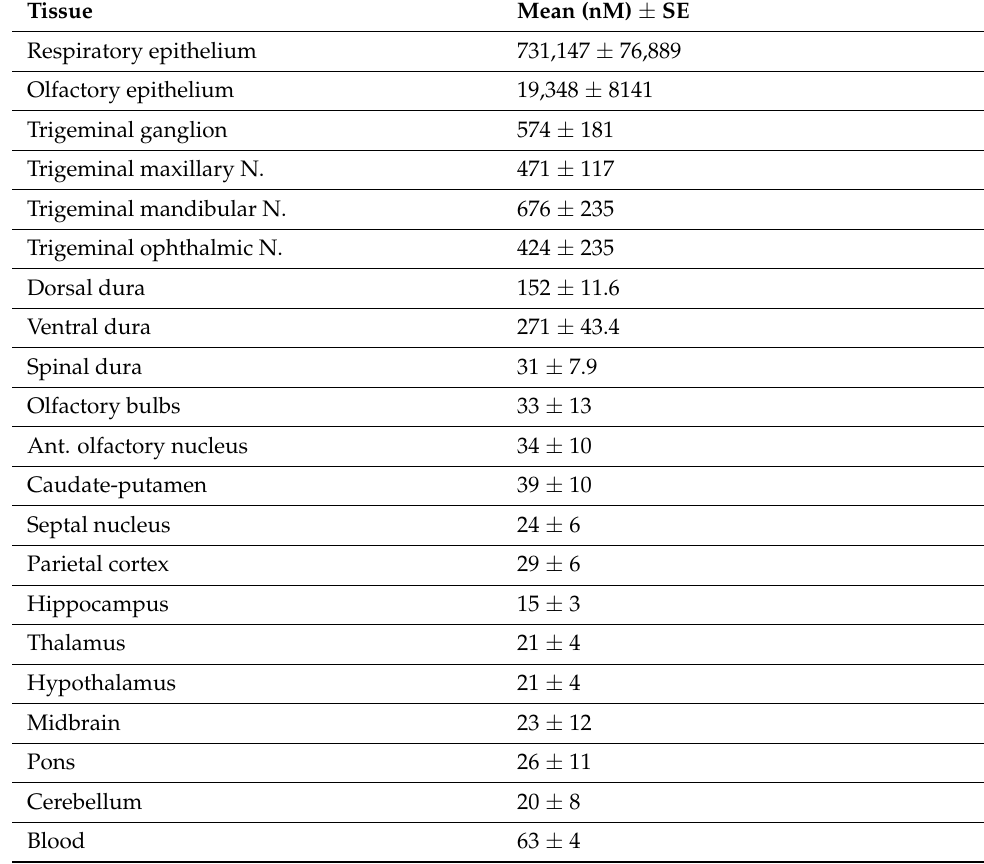
Table 1. Uptake of radiolabeled oxytocin after intranasal administration in rats. Intranasal I-125- oxytocin is initially concentrated in the respiratory and olfactory epithelium. Labeled oxytocin is preferentially taken up by the trigeminal system and is also present in the hippocampus, thalamus midbrain and pons, key regions in the pain processing pathway. Note that a relatively high value in the blood is likely reflective of oxytocin fragments as the compound is rapidly degraded in the